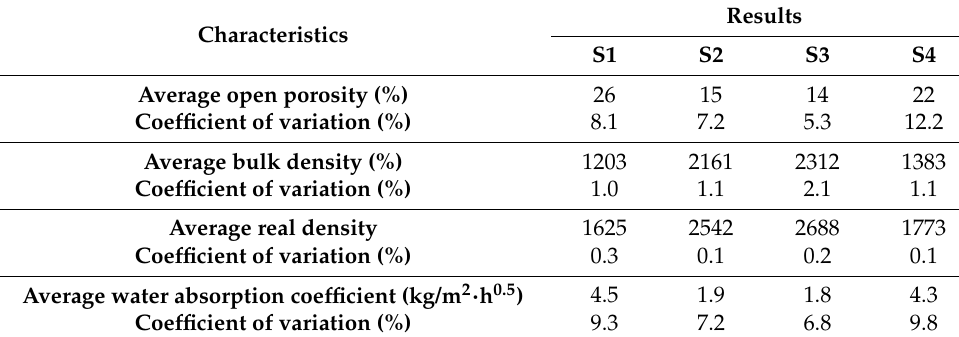
Table 4. The physical characteristics of the